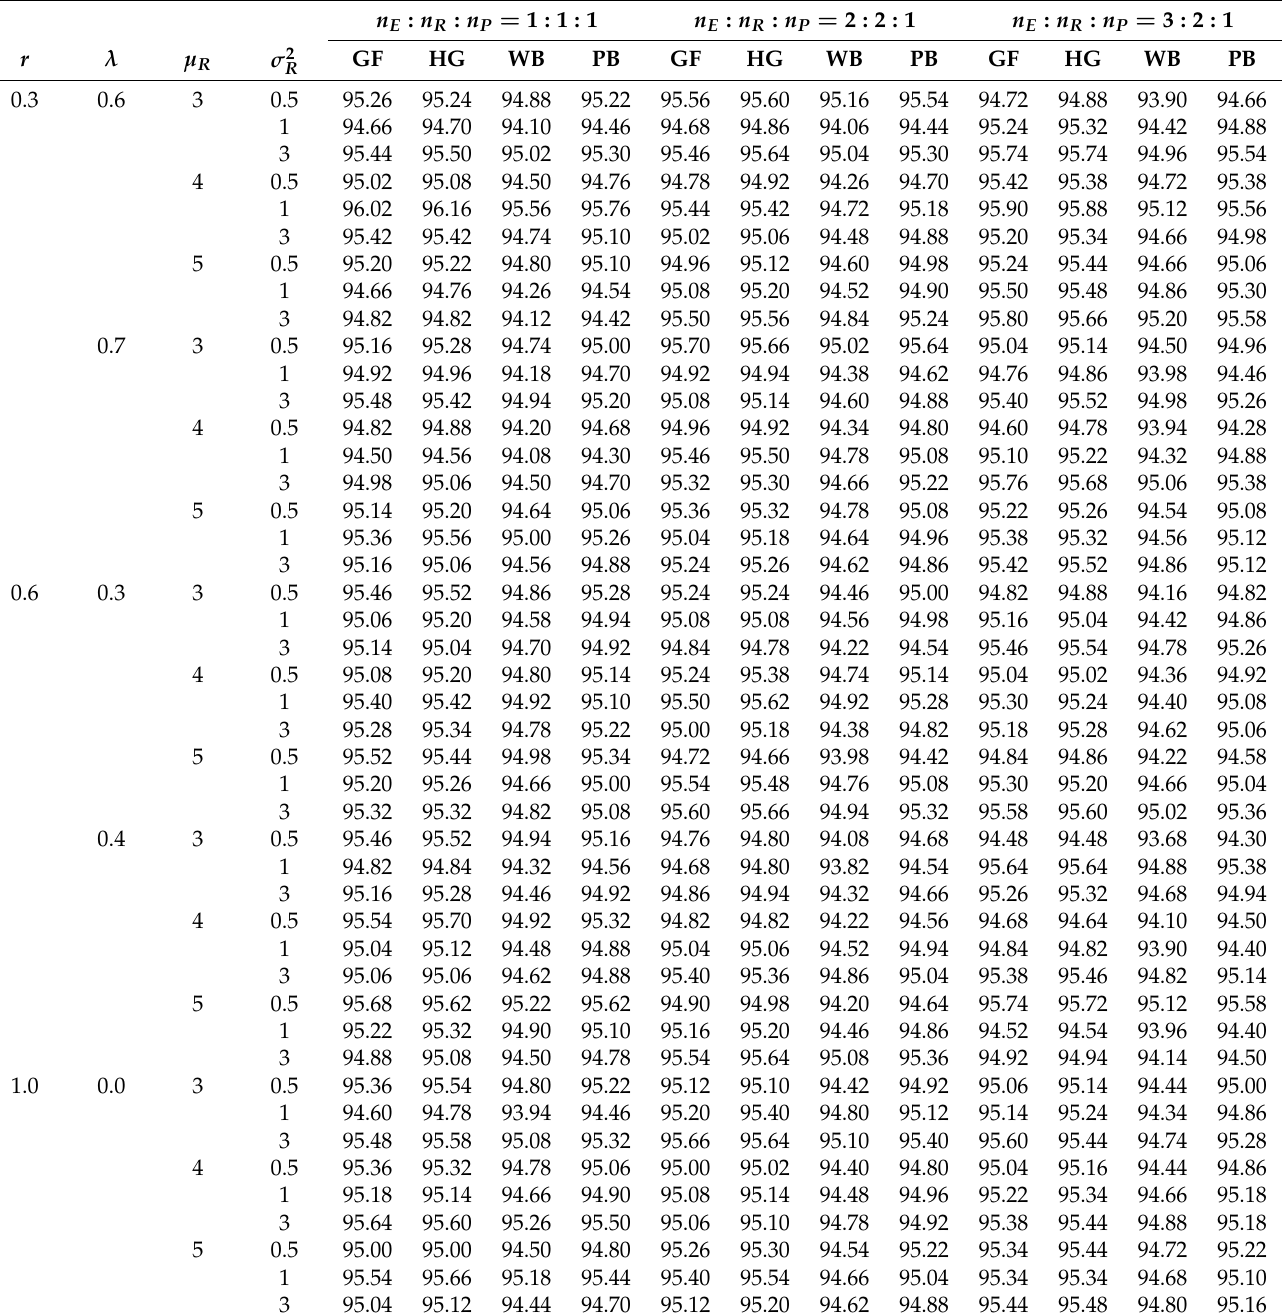
Table 2. Empirical coverage probabilities of four 95% simultaneous confidence regions for φ and ψ under various settings with n =